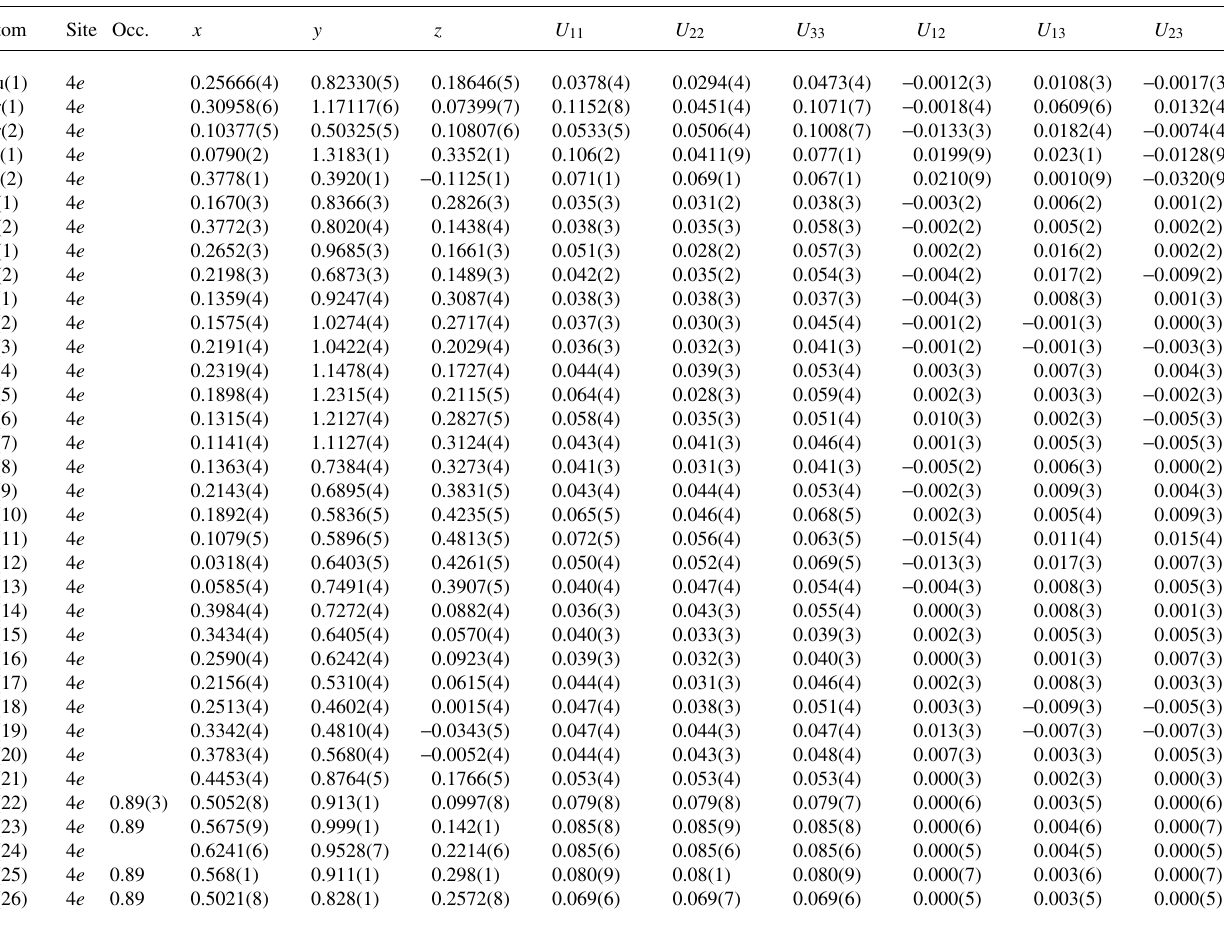
Table 3. Atomic coordinates and displacement parameters (in Å 2 )